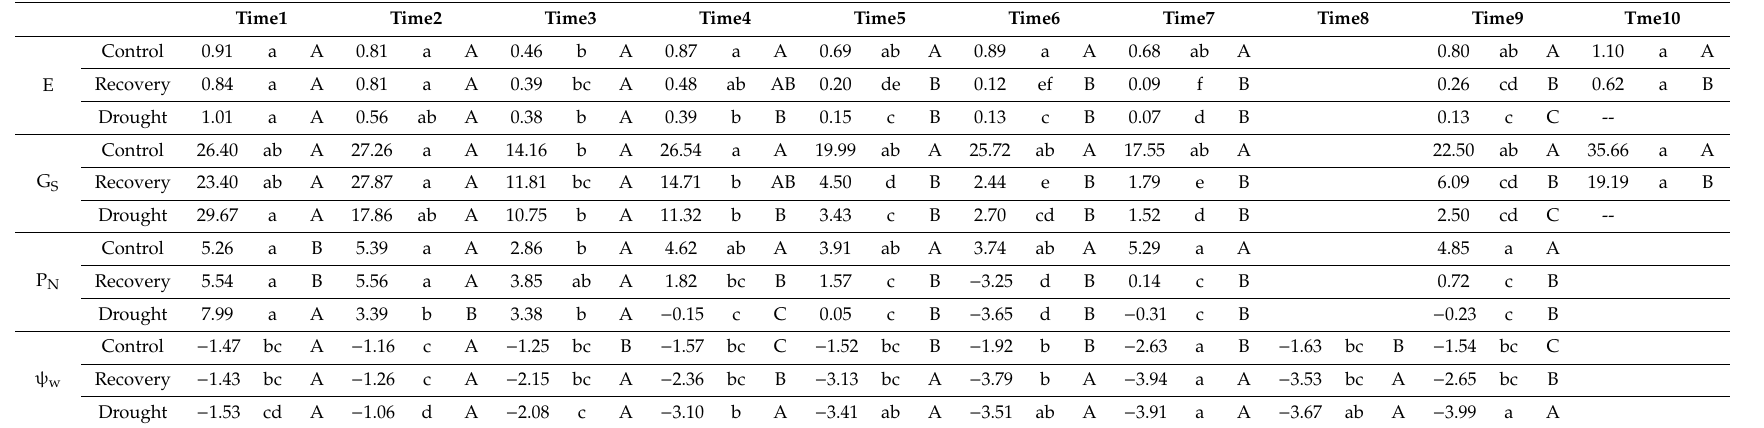
Table 4. Mean values for the di ff erent treatment used. Means with at least one identical lowercase letter within a column are not significantly di ff erent from each other time points. Means with at least one identical uppercase letter within a row of one trait are not significantly di ff erent from each other between treatments ( p <